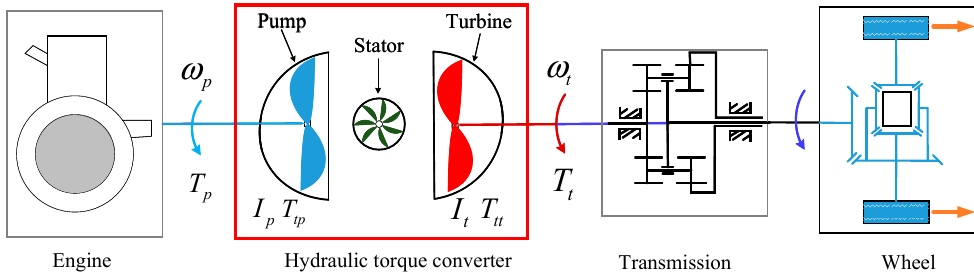
Figure 3. Typical structure of the hydraulic torque converter (HTC) in a vehicle. ω p is the pump wheel angular velocity, ω t is the turbine angular velocity, T p is the torque in the pump, T t is the turbine output torque, T tp is the torque transferred by the pump (impeller), T tt is the torque transferred by the turbine, I p , I t are the inertia of the pump and turbine, respectively.